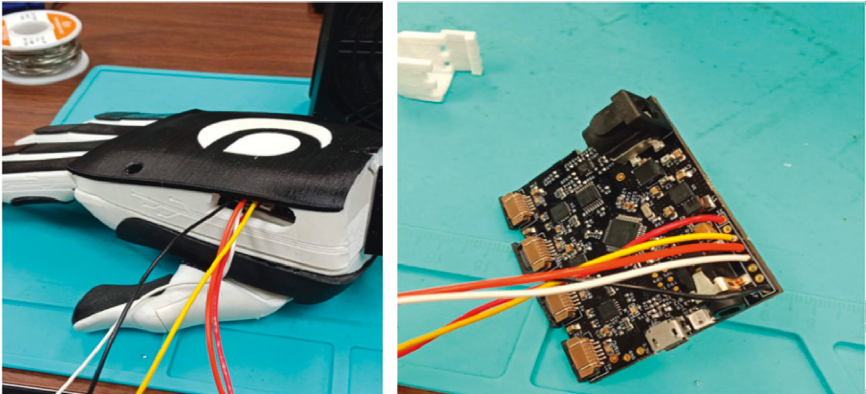
Figure 4: Brunel Hand 2.0 and modified control board.